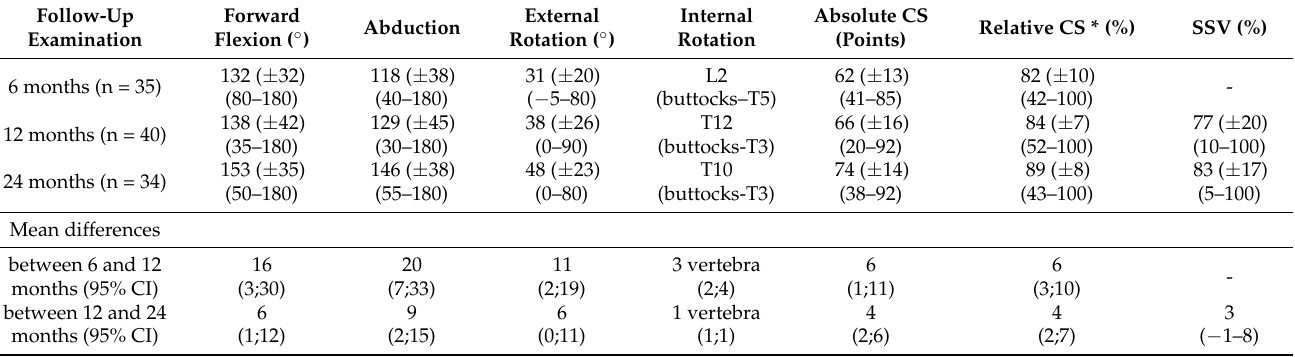
Figure 2. Improvement of absolute Constant–Murley Score, forward flexion and external rotation from 6 over 12 to 24 months. Minimum, maximum and average are displayed in the boxplot. Outlier are displayed as rhombus. Table 2. Clinical results and mean of diefferences with regards to Constant–Murley Score, Subjective Shoulder value and SSV after 6 months, one and two